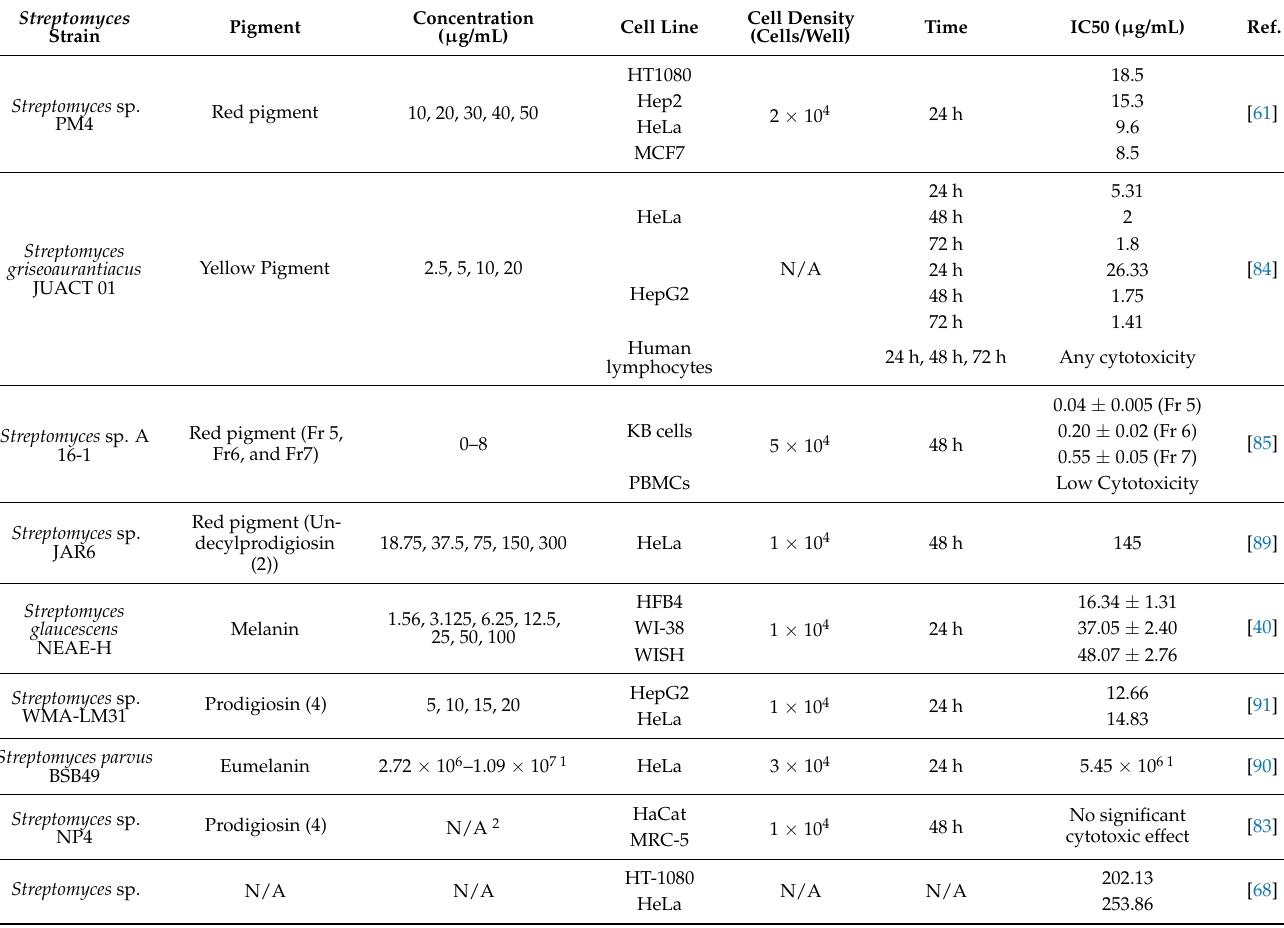
Table 10. IC 50 ( µ g/mL) of Streptomyces -derived pigments and their conditions (cell lines and cell density, among